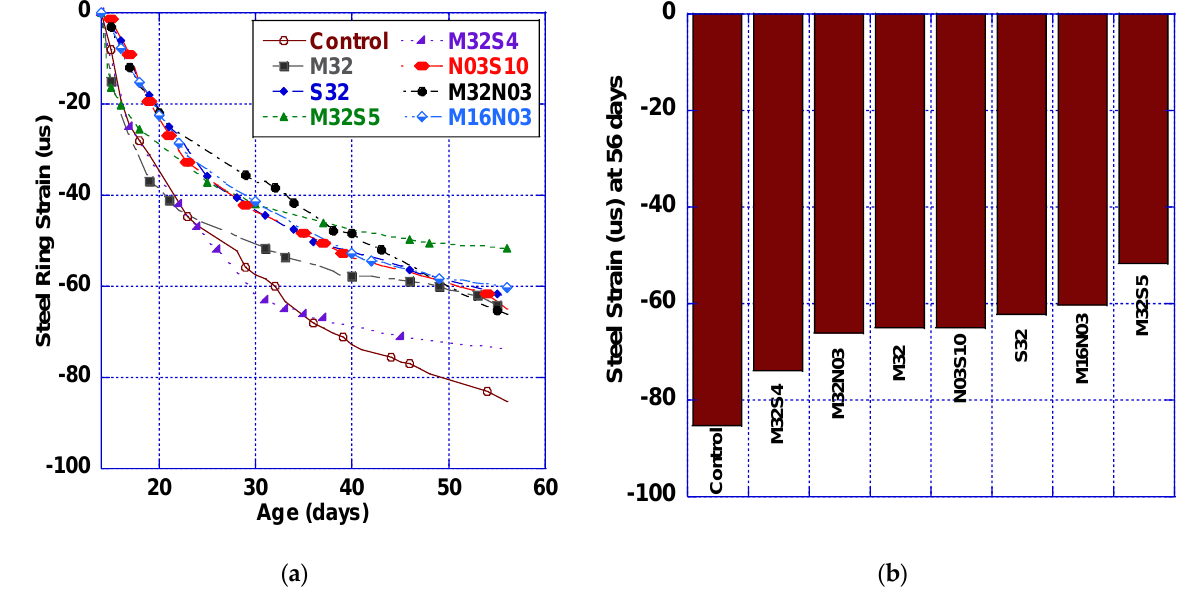
adding hybrid fibers reduced the concrete stresses, which was also reflected in the cracking area observed on the ring surfaces.